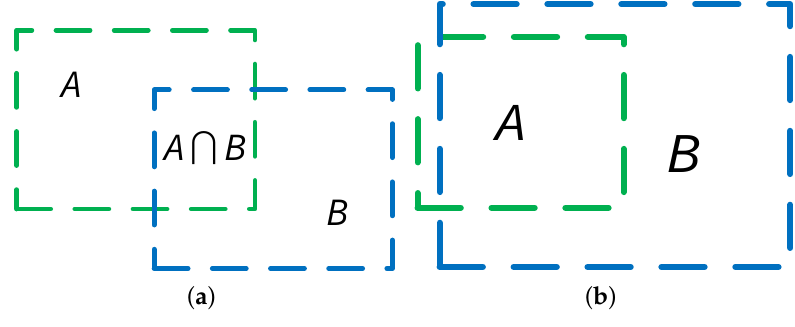
Figure 7. Two bounding boxes with overlapping